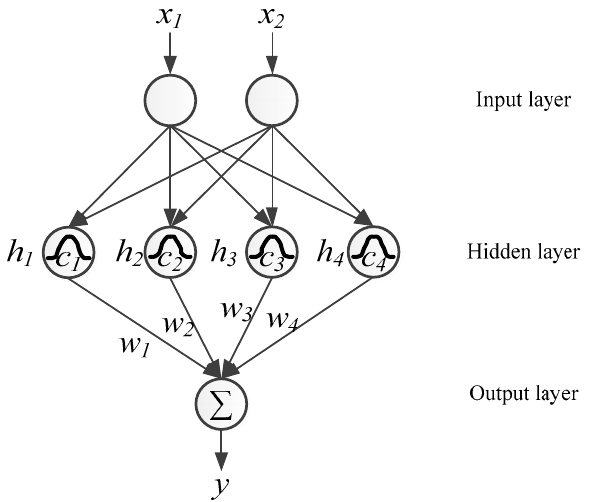
Figure 12. Proposed RBFNN configuration.